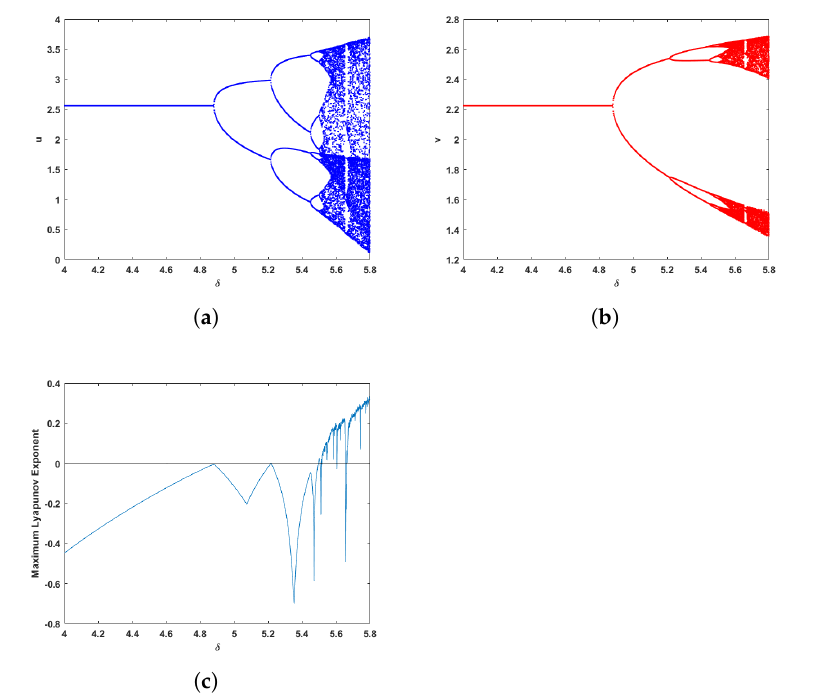
Figure 1. ( a , b ) Bifurcation diagram corresponding to u and v in system (2) with δ ∈ [4, 5.8], r 1 = 0.8, r 2 = 0.8, a = 0.4, b = 0.2, c = 2, d = 0.1, k = 5, h 1 = h 2 = 0, the initial value is ( u , v ) = (3, 2). ( c ) Maximum Lyapunov exponents corresponding to ( a ).